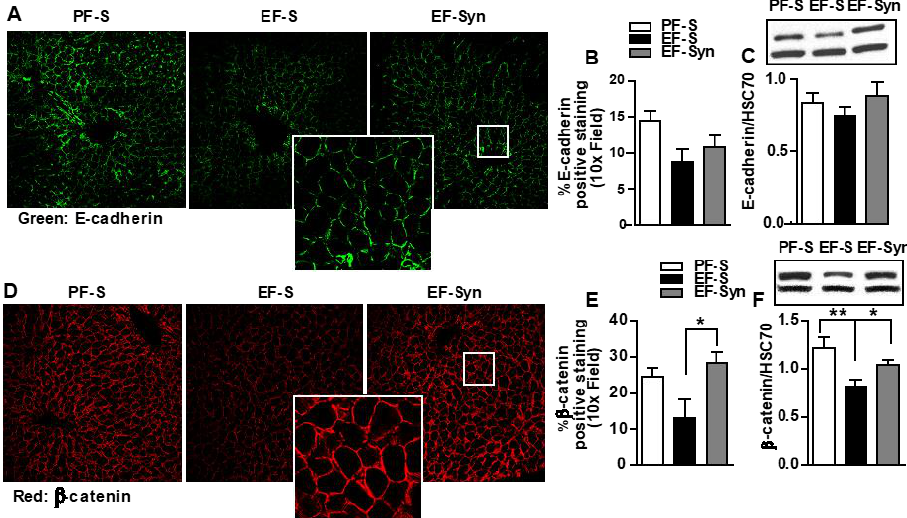
Figure 2. Cellular junctional proteins in mouse liver. Mice were treated as described in Figure 1. Liver